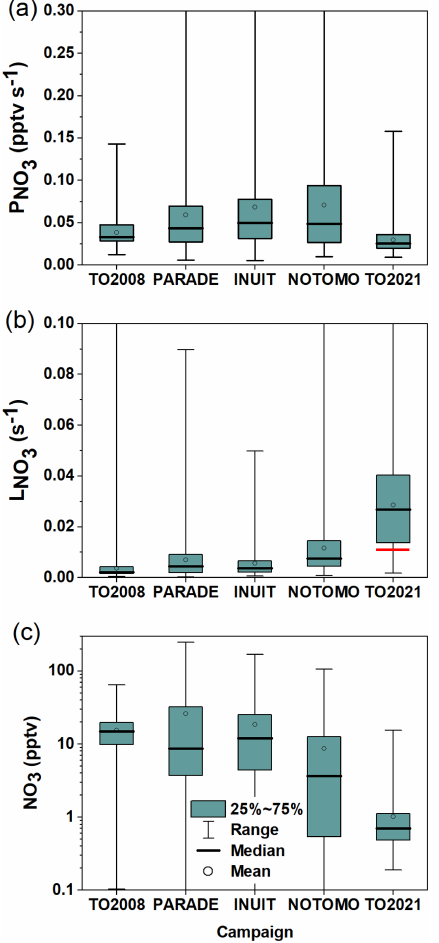
Figure 13. NO 3 production rates (a) , loss rates (b) , and mixing ra- tios (c) measured during five campaigns on the summit of Kleiner Feldberg between 2008 and 2021. Boxes represent the range be- tween the first and third quartiles, and whiskers denote the full range of values. The red line represents the median of directly measured k NO 3 during TO2021 at